Question: What does this figure show? Answer in one sentence.
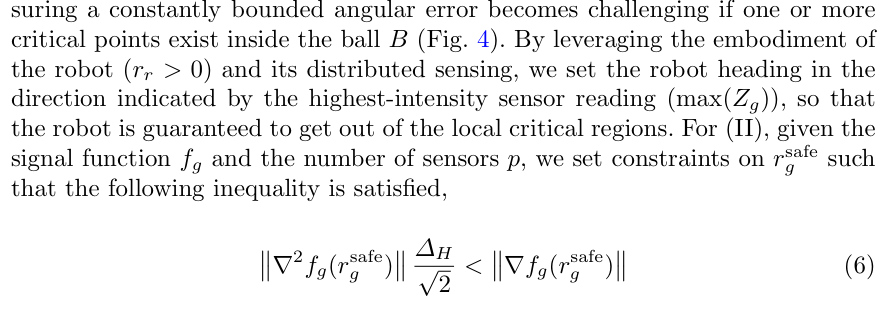
Answer: shows how, for a given number of sensors, gradient estimate deteriorates in the critical regions of scalar field Fg.